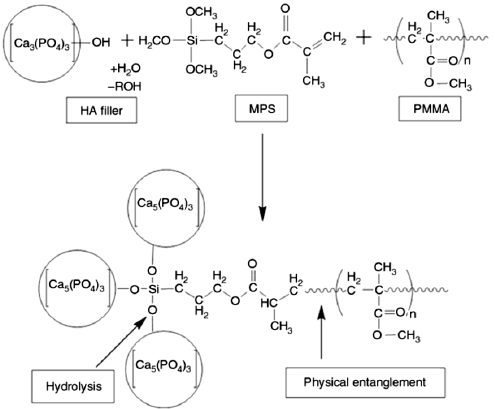
Figure 3: Inter action of Hydroxyapatite  MPS and PMMA.